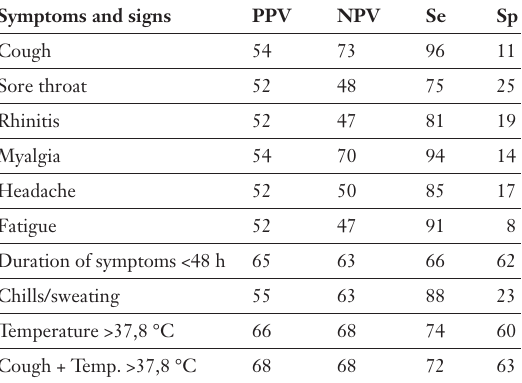
Figure 1 ROC curve, model with the two vari- ables: time-period of consultation (weeks 49–51, 52–1 and >1) and duration of symptoms before first medical atten- dance (<24 h, 24–48h, >48h).